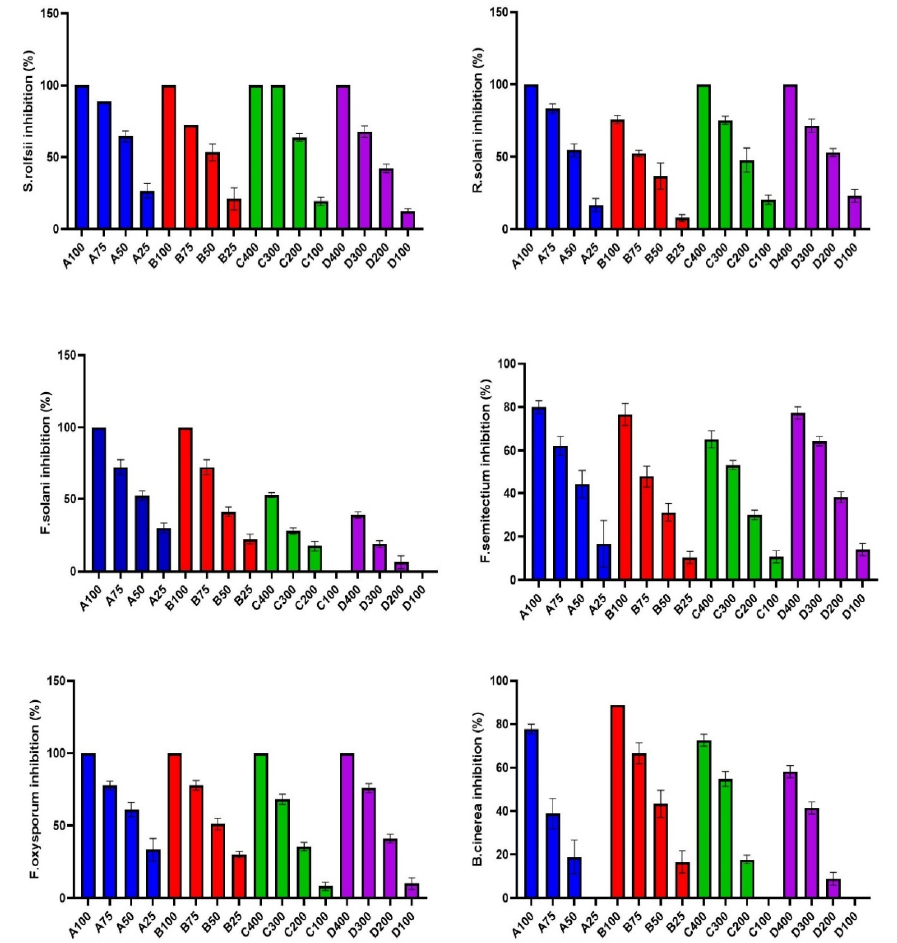
Figure 3. Mycelial growth % inhibition with different concentrations ( µ L/mL) of citrus essential oils (A: C. lemon , B: C. aurantifolia , C: C. maxima , D: C. sinensis ) against different phytopathogenic fungi. Table 2. IC 50 of Citrus essential oils and hexosomal dispersion of C. lemon against different phytopathogenic fungi.